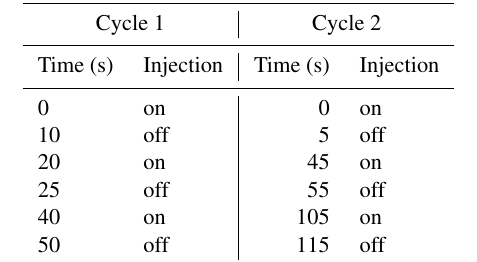
Table 1. Toluene injection